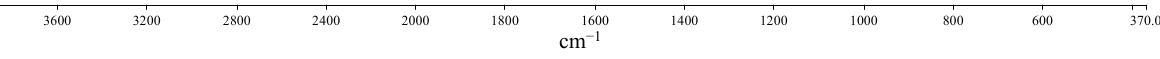
Figure 2. Fourier transform infrared (FTIR) spectra of purified MBF-UFH produced by Bacillus sp.